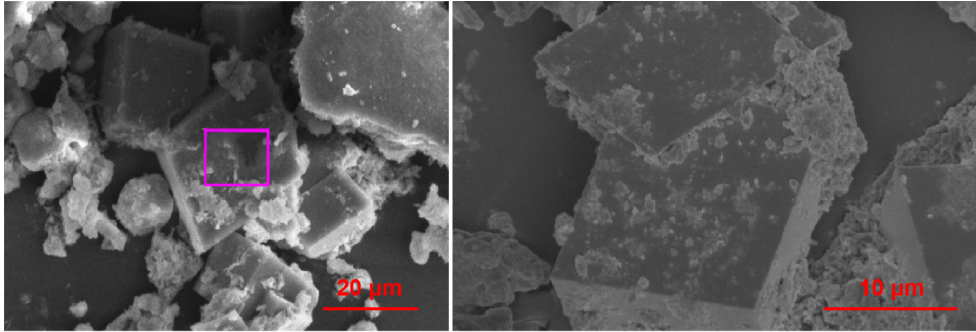
Figure 9. SEM of calcium chloroaluminate solidified Pb.